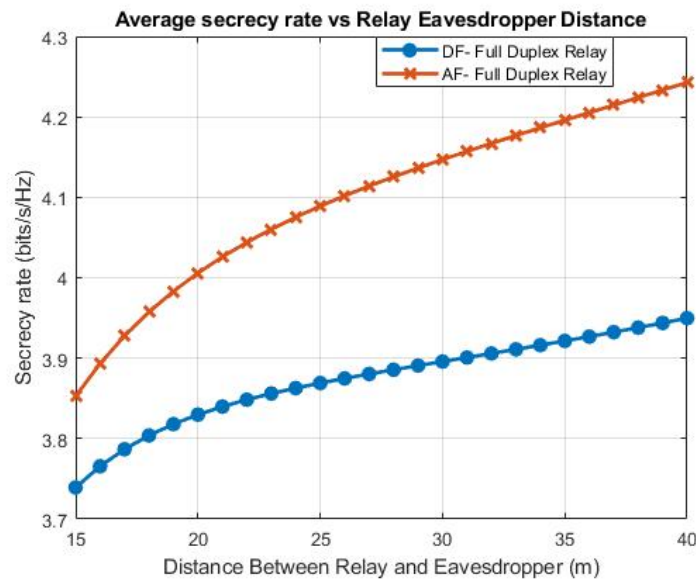
Figure 9. Secrecy Rate vs d R 2 E for the EH System .